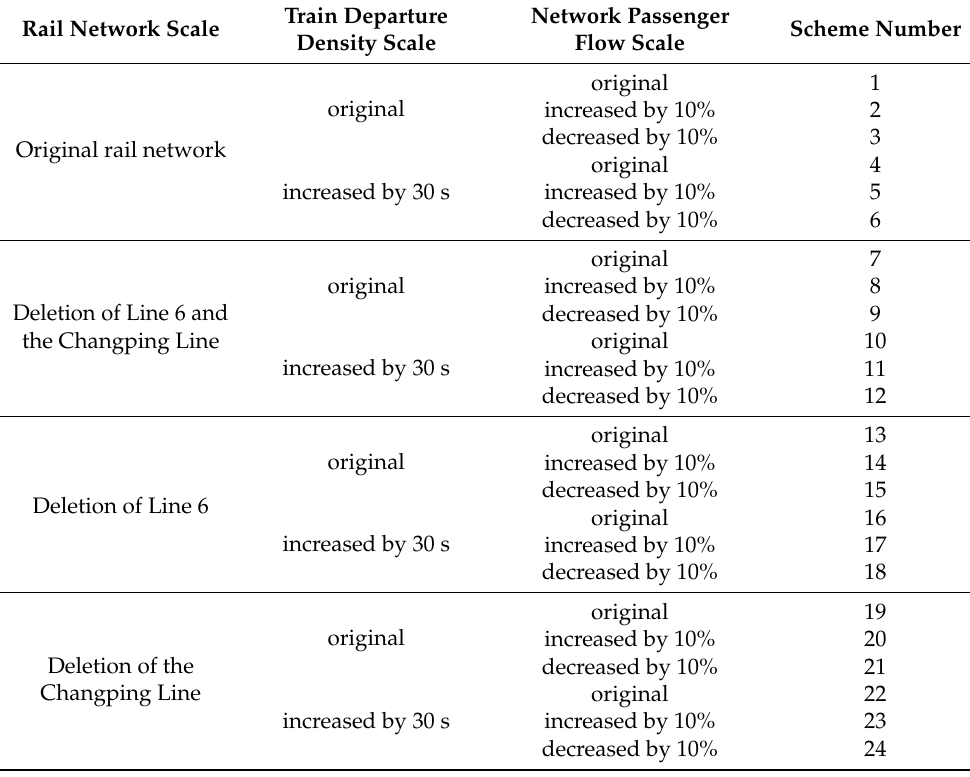
Table 6. Simulation scheme of hybrid optimization strategy.